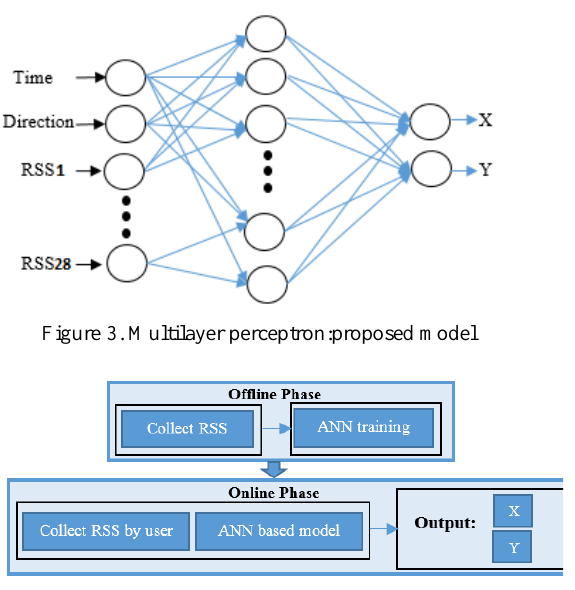
Figure 4. Process flowchart of the proposed method